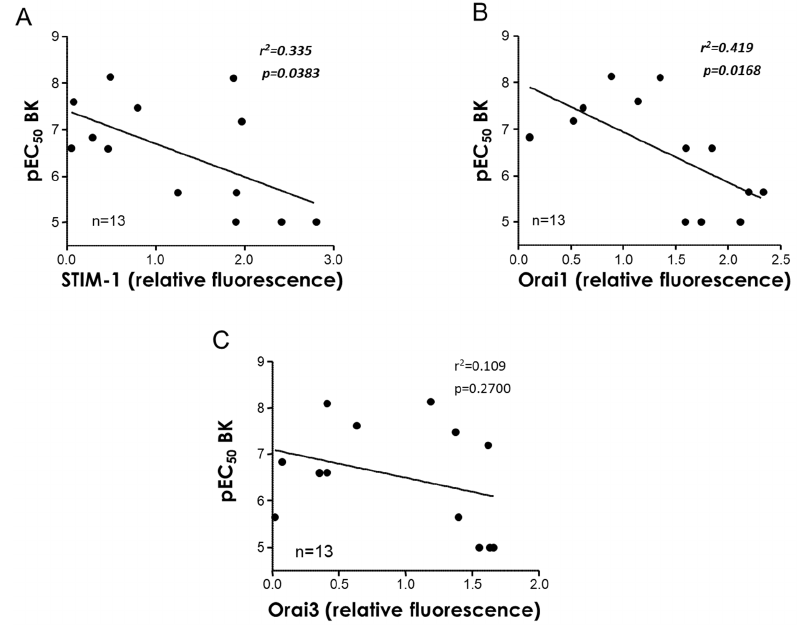
Figure 4. STIM1 and Orai1 are associated with vascular function in human mesenteric arteries. Simple regression analysis for STIM-1 ( A ), Orai1 ( B ), and Orai3 ( C ) fluorescence intensity normalized by the number of nuclei in the mesenteric arteries with respect to endothelium-dependent vasodilation, determined as –log molar of concentration required to obtain 50% relaxation (pEC 50 ) for bradykinin (BK) in isolated mesenteric arteries obtained from the same subject. Coefficients of determination (r 2 ) and p values (in bold italic when significant) are indicated for each association. n indicates the number of subjects for the determinations.